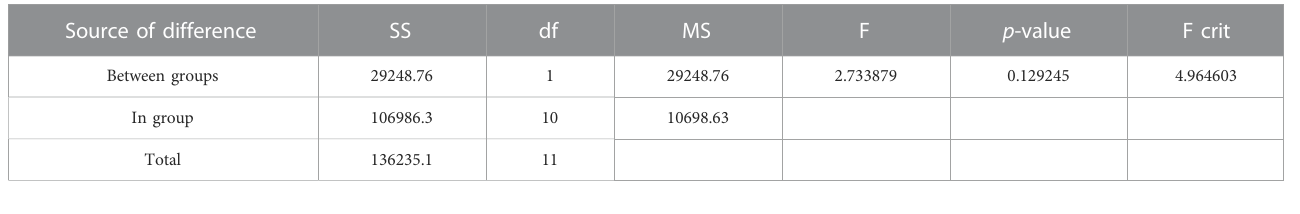
TABLE 13 Variance analysis of ultrasonic power on point B and point D.